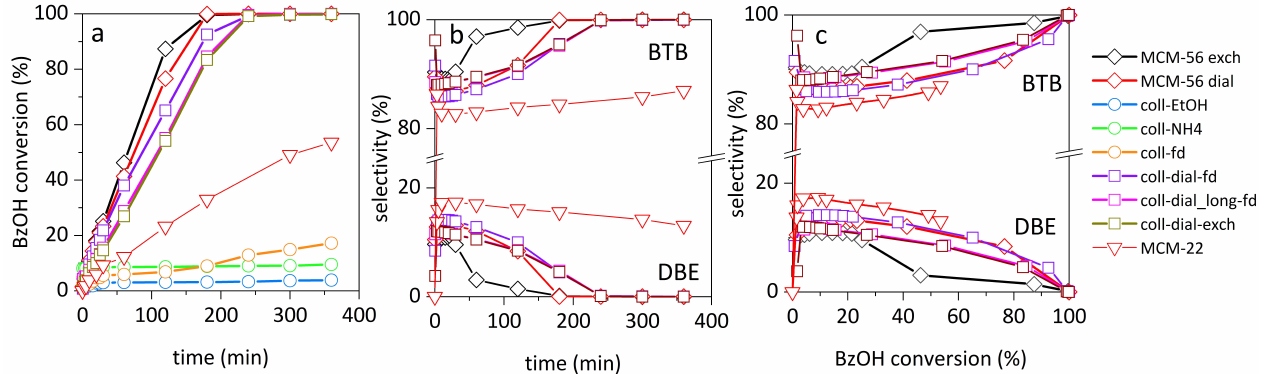
Figure 4. Catalytic test results. ( a ) selectivity of benzyl alcohol (BzOH) vs. time of reaction for all investigated catalysts, ( b ) selectivity to 2-benzyl-1,3,5-trimethylbenzene (BTB) and dibenzyl ether (DBE) vs. time, ( c ) selectivity to 2-benzyl-1,3,5- trimethylbenzene (BTB) and dibenzyl ether (DBE) vs. conversion of benzyl alcohol